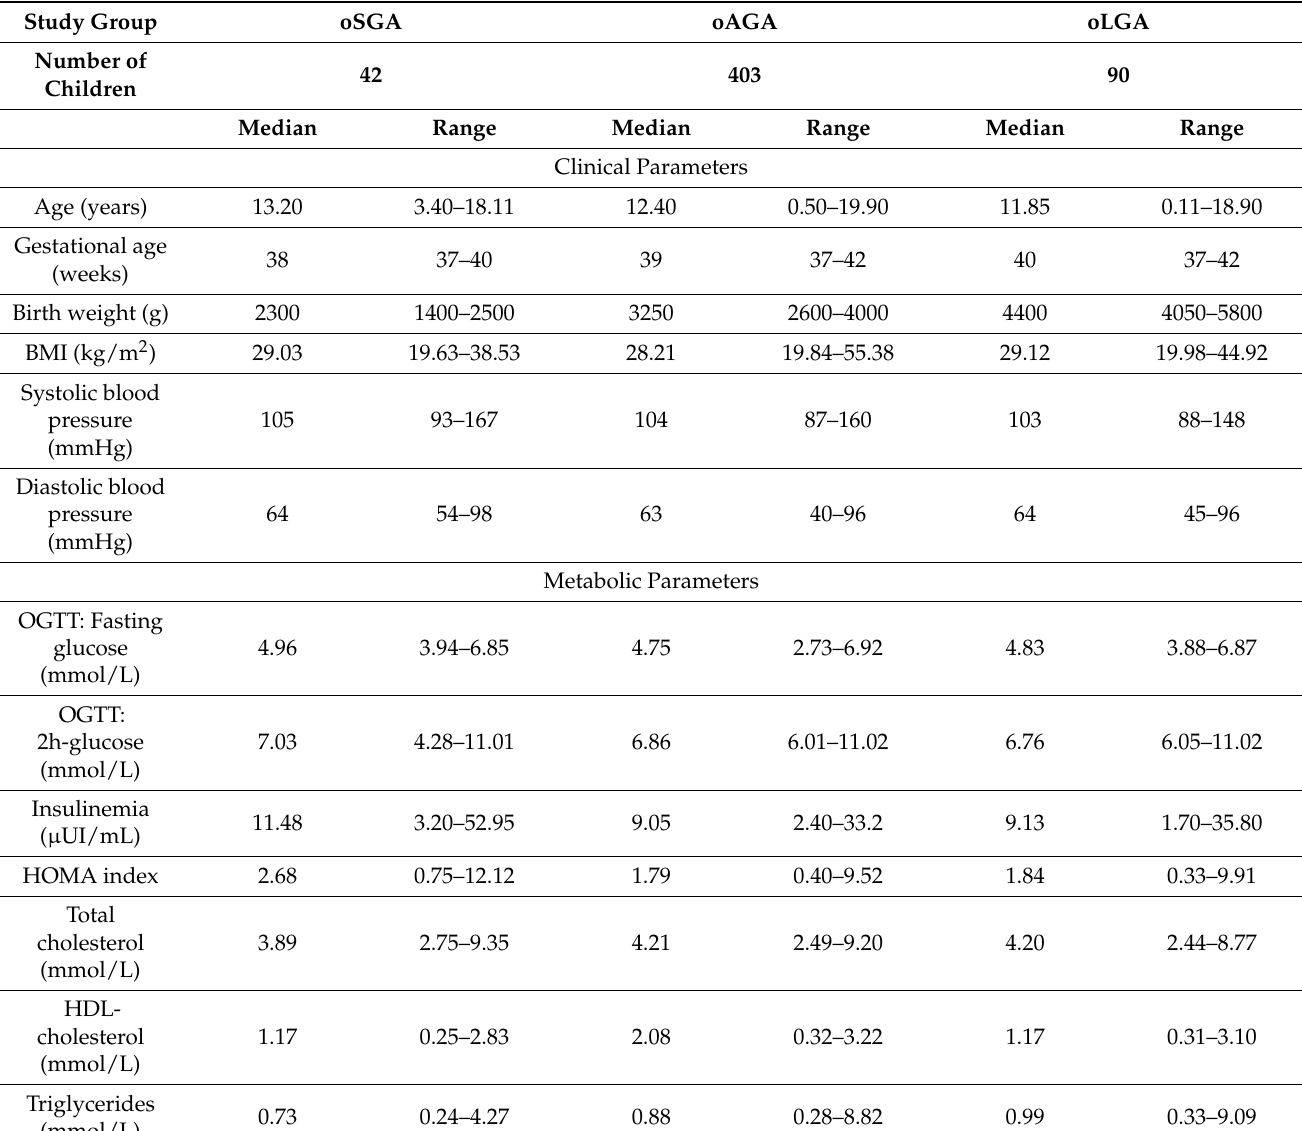
Table 1. Clinical and biological features of the study groups according to birth weight (BW) for gestational age